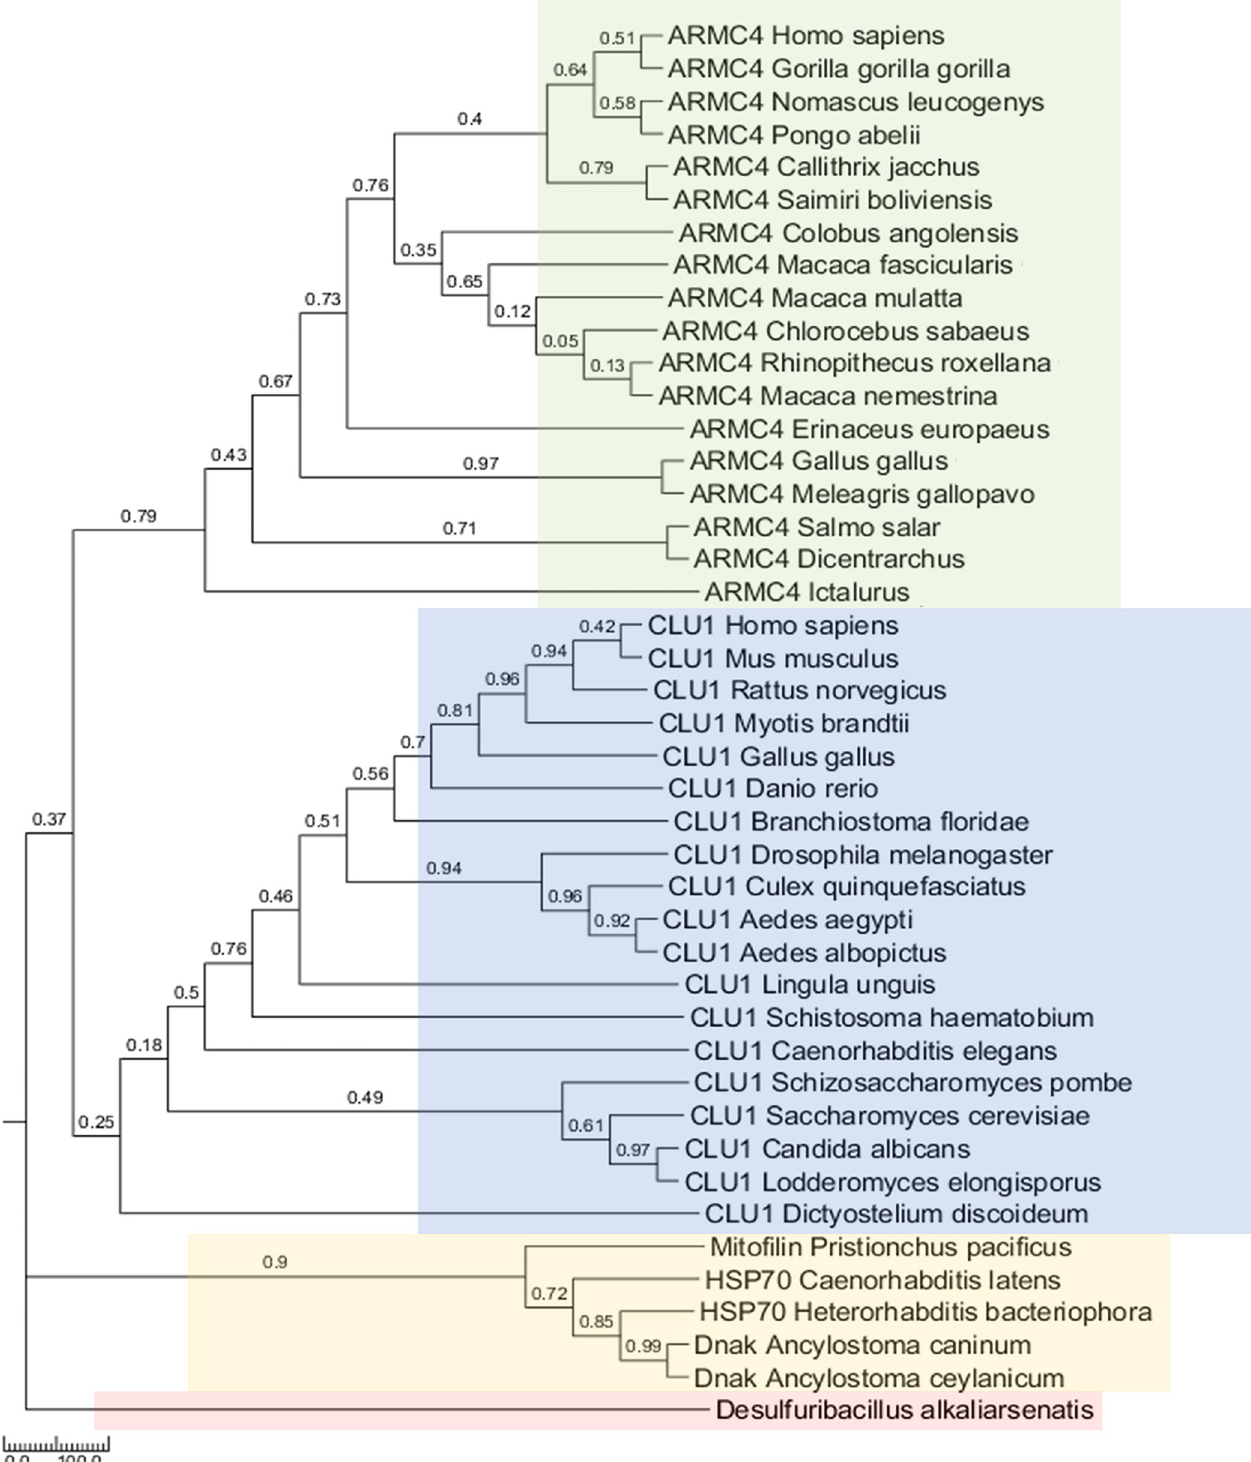
PLOS ONE | https://doi.org/10.1371/journal.pone.0262138 January 20,